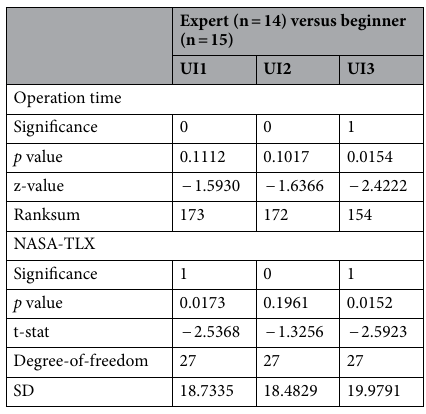
Table 4. Comparison of responses between expert and